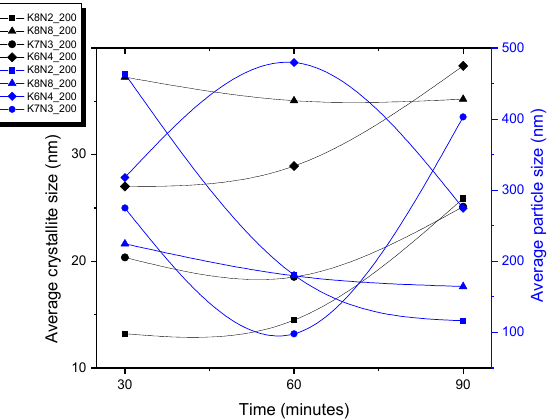
Figure 11. Average of crystallite size and particle size of all samples at 200 °C, depending on the HTMW dwelling time (30–90 min).